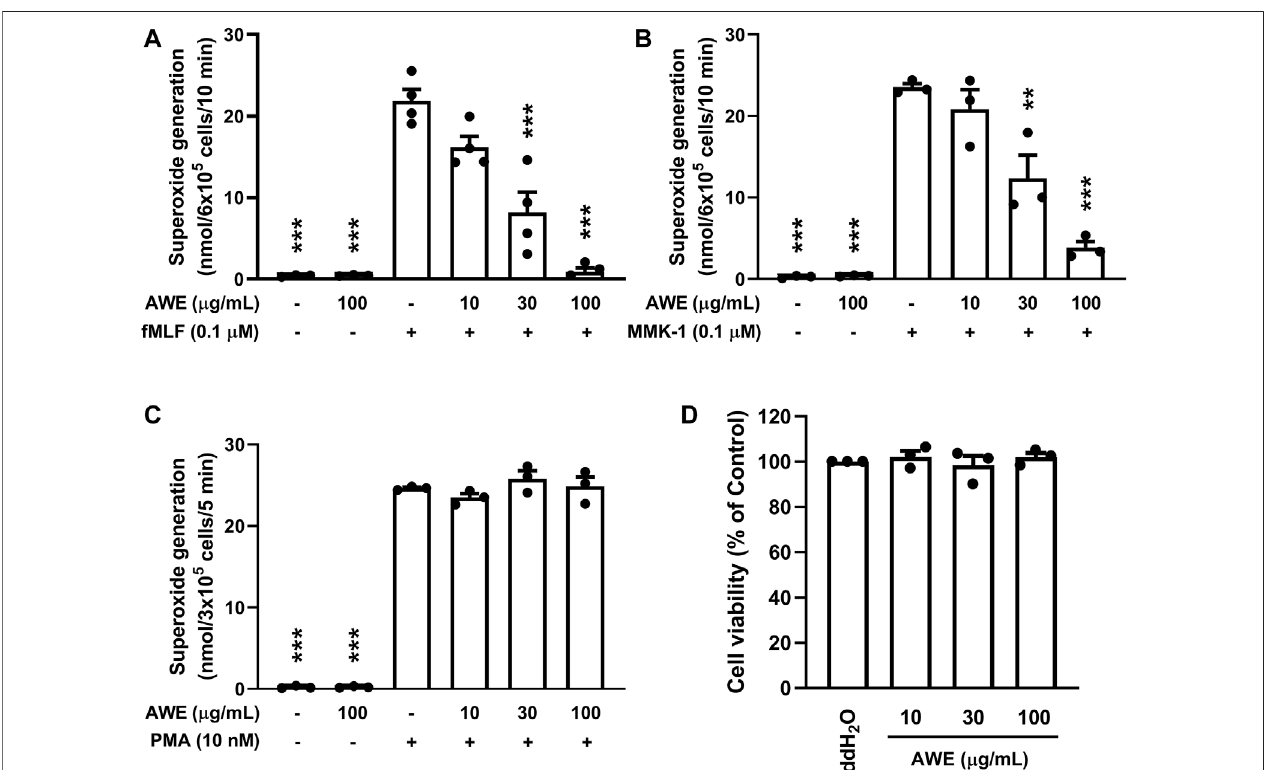
FIGURE 2 | AWE inhibited superoxide anion generation in activated human neutrophils. Human neutrophils (3 × 10 5 or 6 × 10 5 cells/mL) were incubated with ddH 2 O (as the control) or AWE (10, 30, or 100 μ g/ml) for 5 min, and then were activated by (A) fMLF, (B) MMK-1 for 10 min, or (C) PMA for 5 min. Superoxide anion productionwasmonitoredusingferricytochromecreductionat550 nm. (D)